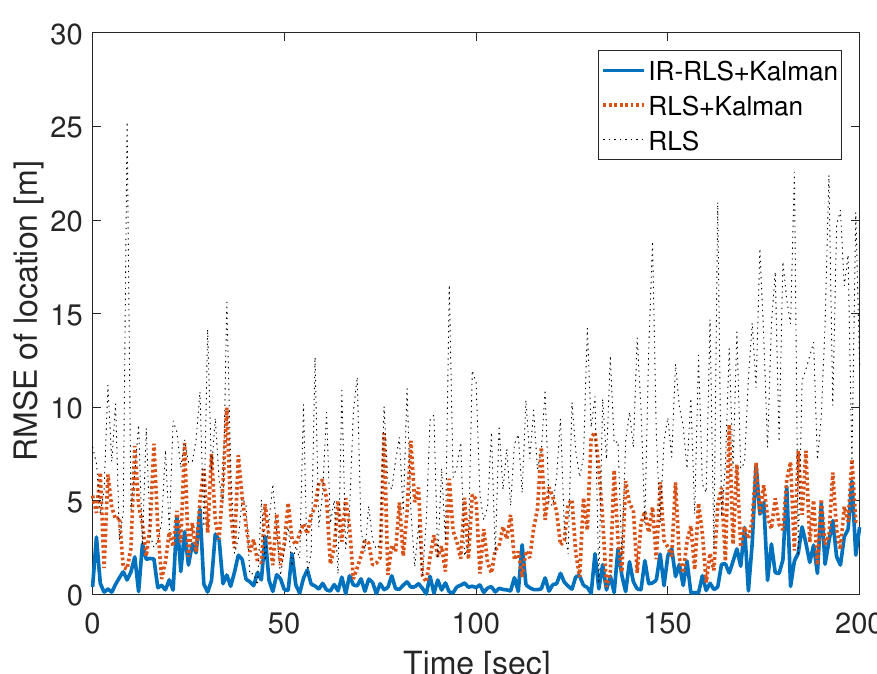
Figure 3. Root mean square error (RMSE) comparison between IR-RLS and RLS methods.